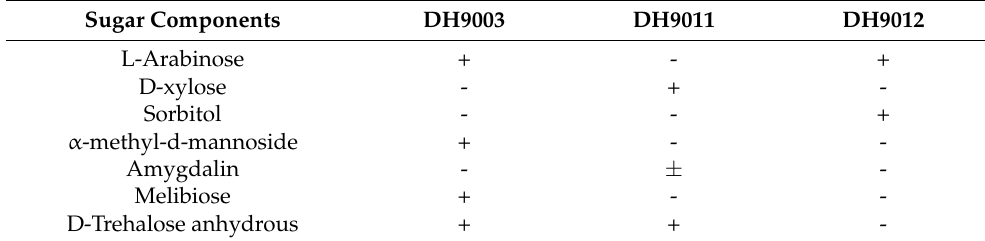
Table 2. Comparisons on fermentation profiles of three bacteriocins producers from lactic acid bacteria. Sugar